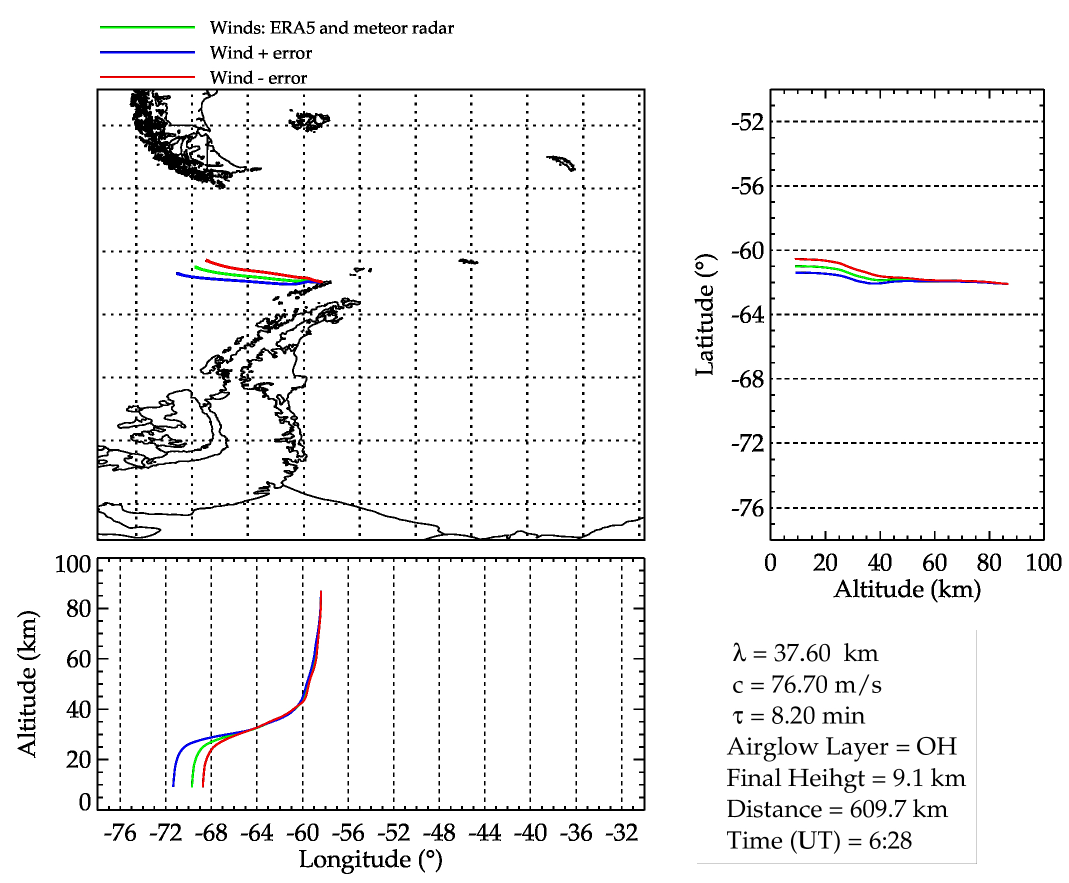
Figure 14. Same as Figure 13, but for wave #